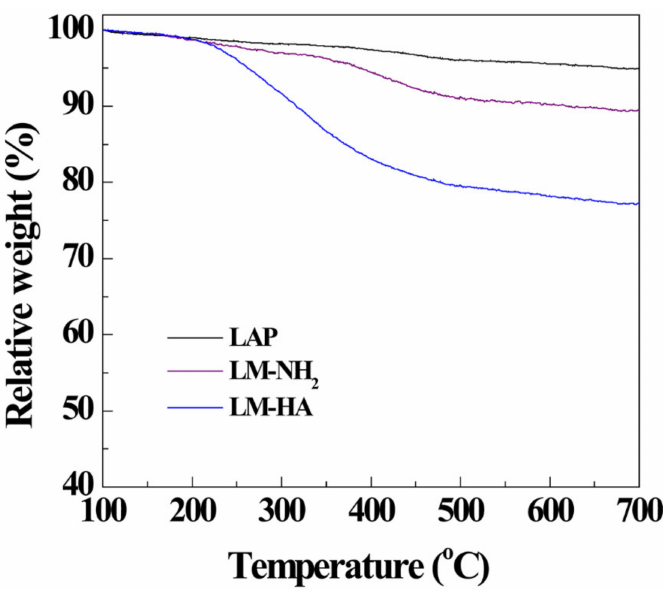
Figure 3. TGA curves of LAP, LM-NH 2 , and LM-HA, respectively.